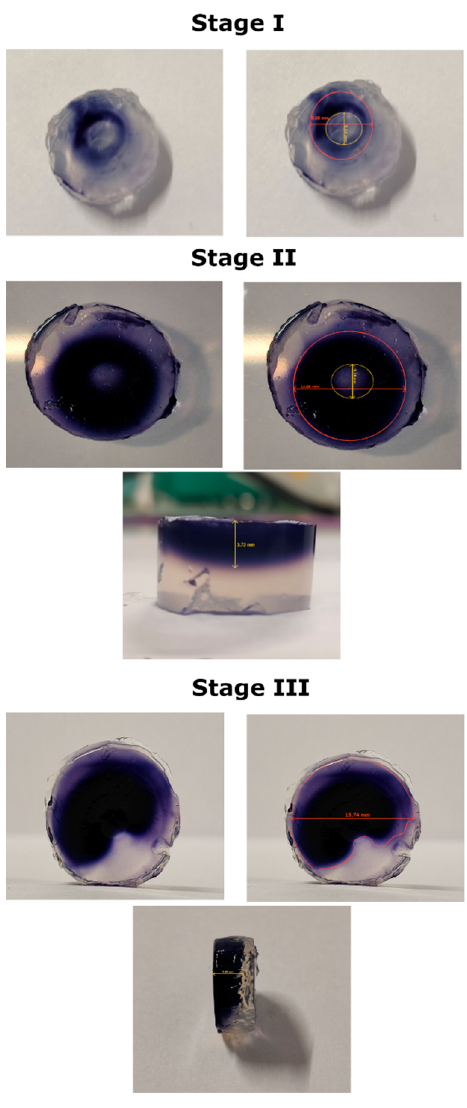
Figure 5. Spatial distribution of ROS in the KI-starch gels. Stage I—photograph from initial generation of FLC-dc-APGD (1 s). Stage II—changes recorded after an average time (2 s) of FLC-dc-APGD generation in a flowing mode. Stage III—variation resulting from a prolonged (4 s) FLC-dc-APGD irradiation. Prior to NTAP exposure, the gels had been covered with a droplet of 0.5% ( m / v ) NH 4 NO 3 . Navy blue tint results from effective ROS generation. The gels were photographed from the front, back, and side views.